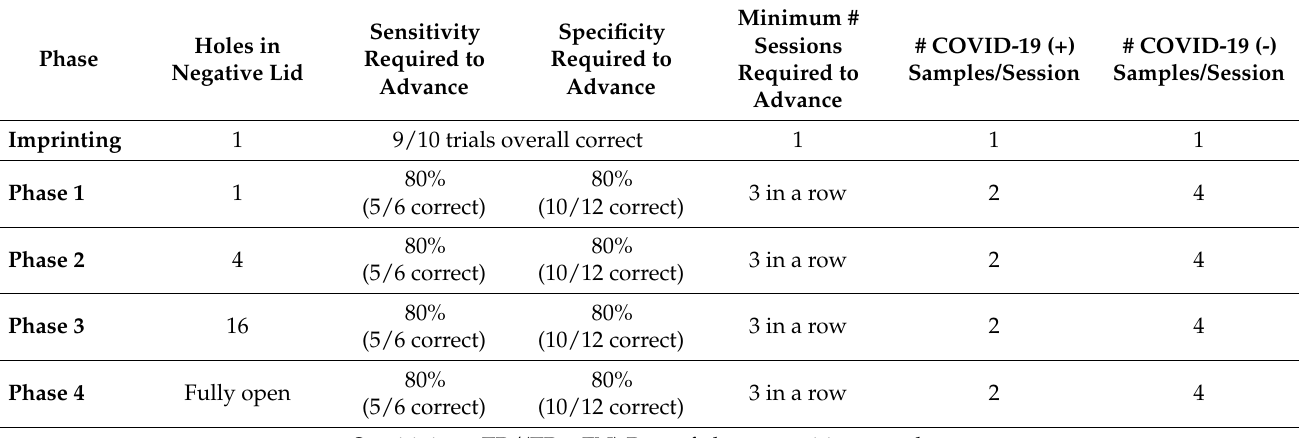
Table 3. Training progression